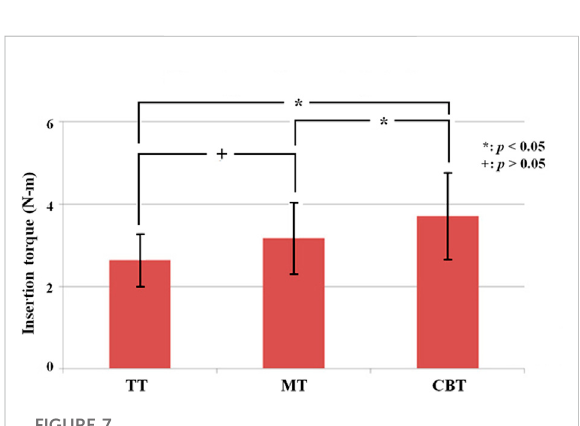
Mean maximal insertion torque of pedicle screws for a single vertebra treated with TT, MT and CBT trajectories. The insertion torquewassigni fi cantlyhigherintheCBTgroupthanintheTT and MT groups. Signi fi cant difference was not observed between the TT and MT groups. factors are responsible for the biomechanical performance of pedicle screw fi xation: screw mechanical characteristics, bone quality and implantation techniques (Shen et al., 2019; Matsukawa et al., 2021; Qiu et al., 2022). In our study, bone quality, pilot methods and screw morphometric data, including thread type/shape and outer/inner diameter, were controlled; only the lengths of the three methods were